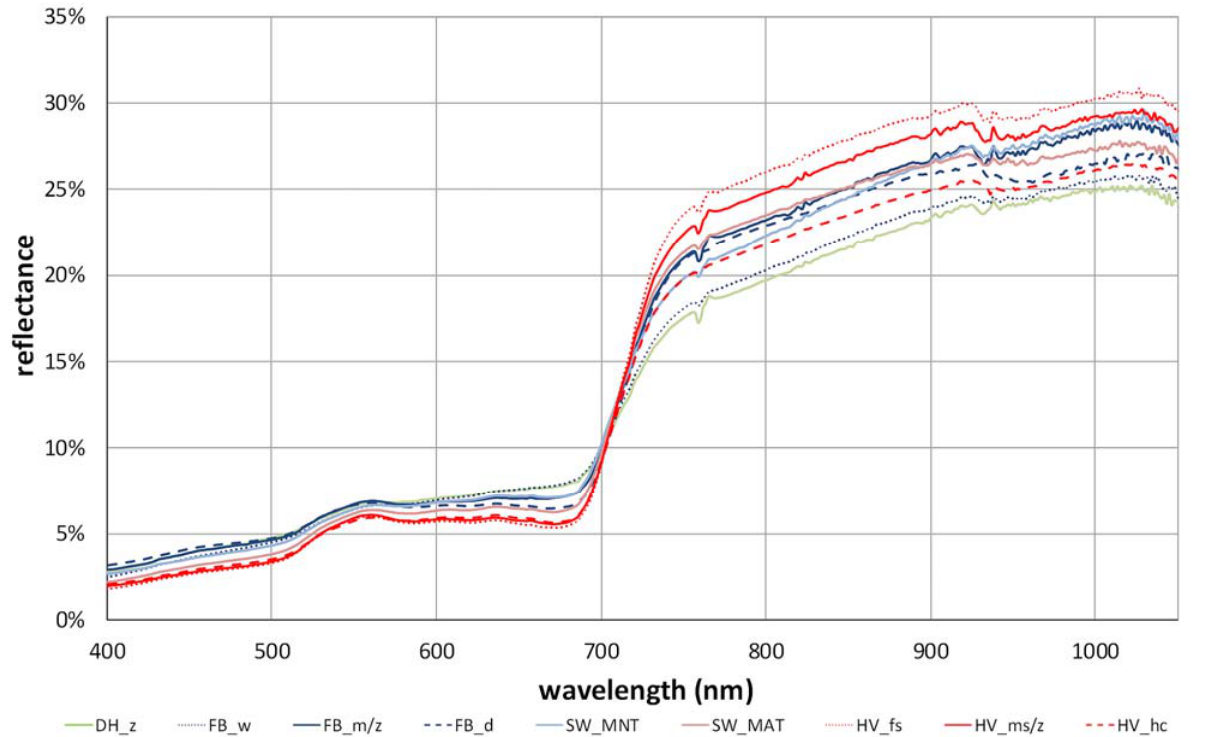
Figure 5. Diagnostic mean reflectance spectra of all nine study sites showing the general spectral characteristics of Alaskan Low Arctic tundra communities along the